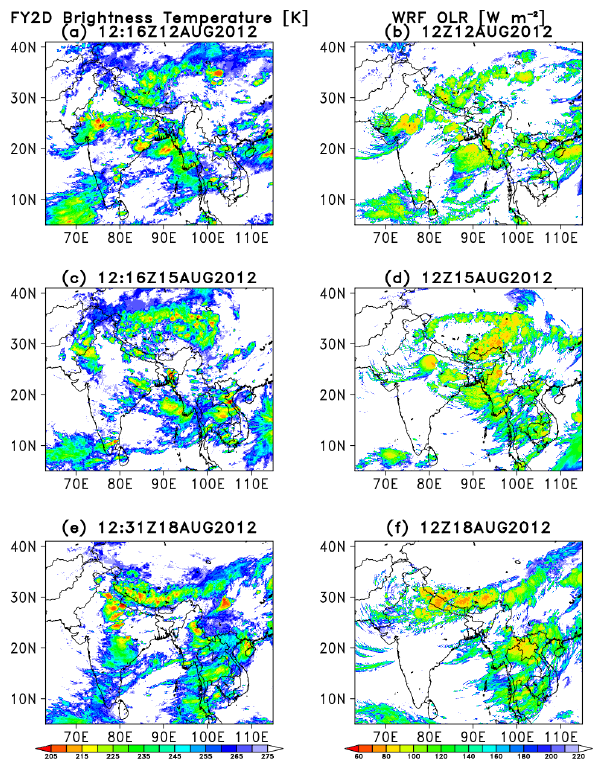
Fig. 5. FY-2D infrared satellite-derived brightness temperature (K; left column) and WRF-simulated outgoing longwave radia- tion (Wm − 2 ; right column) for 12:00UTC 12 August ( a and b ), 12:00UTC 15 August ( c and d ), and 12:00UTC 18 August ( e and f